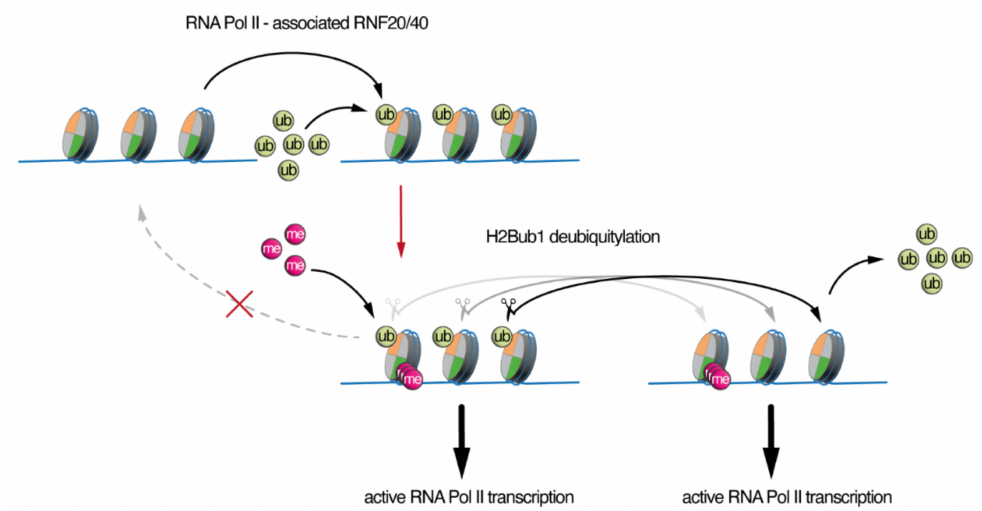
Figure 3. Asymmetric function of H2Bub1 deposition and deubiquitylation. H2B ubiquitination is associated with active RNA polymerase II transcription. H2Bub1 facilitates the trimethylation of H3K4 (the histone tail cross-talk is labeled with a red arrow). Removal of monoubiquitin (ub) from histone H2Bub1-containing nucleosomes by the ATXN7L3-dependent SAGA DUB module and the related ATXN7L3-regulated DUBs do not significantly affect the status of H3K4 trimethylation, or RNA polymerase II transcription. However, H2Bub1 deubiquitination does not recreate the original nucleosome state, but instead, could impact the levels of free ub in the